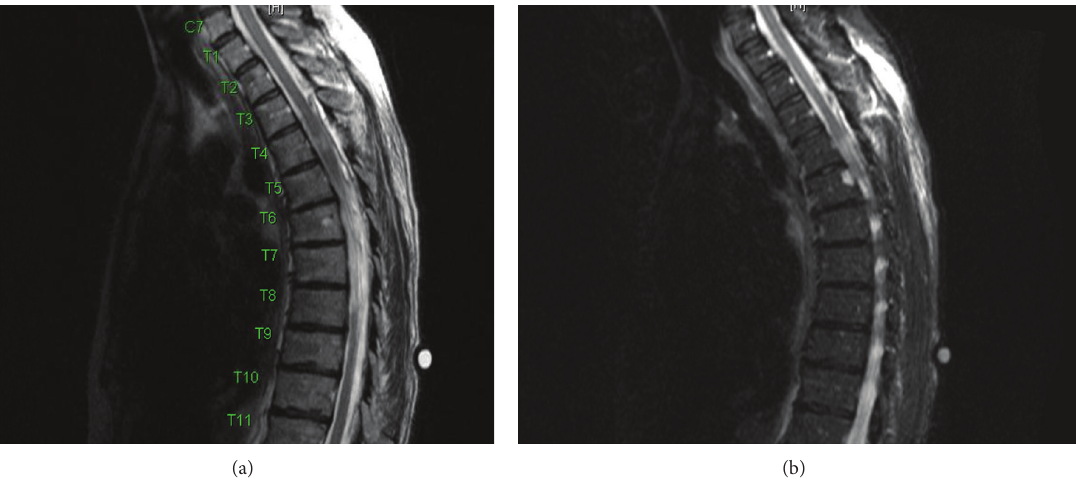
Figure 5: (a) Post-op sagittal T2 MRI with complete dural closure and complete tumor resection. (b) Post-op sagittal T2 MRI with complete dural closure and complete tumor